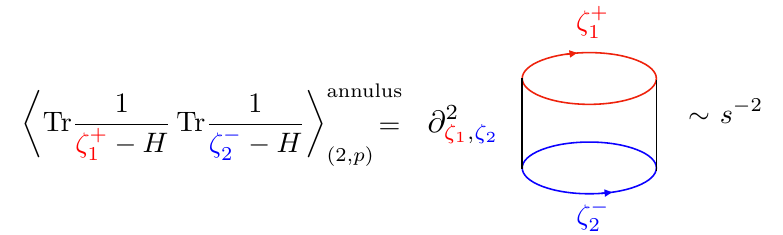
Figure 3: The annulus contribution to the spectral two-point function. Its universal part gives the correct EFT singular contribution of − 1 / 2 s 2 . The diagram is identical to (2.22), although here it represents a minimal-string worldsheet interpreted as a 2D spacetime with two branes, also known as the Laplace transform of a Euclidean wormhole. The 2D gravity amplitude gives the same leading singularity including the numerical coefficient as (2.22), coming from the Goldstone sector of causal sym-